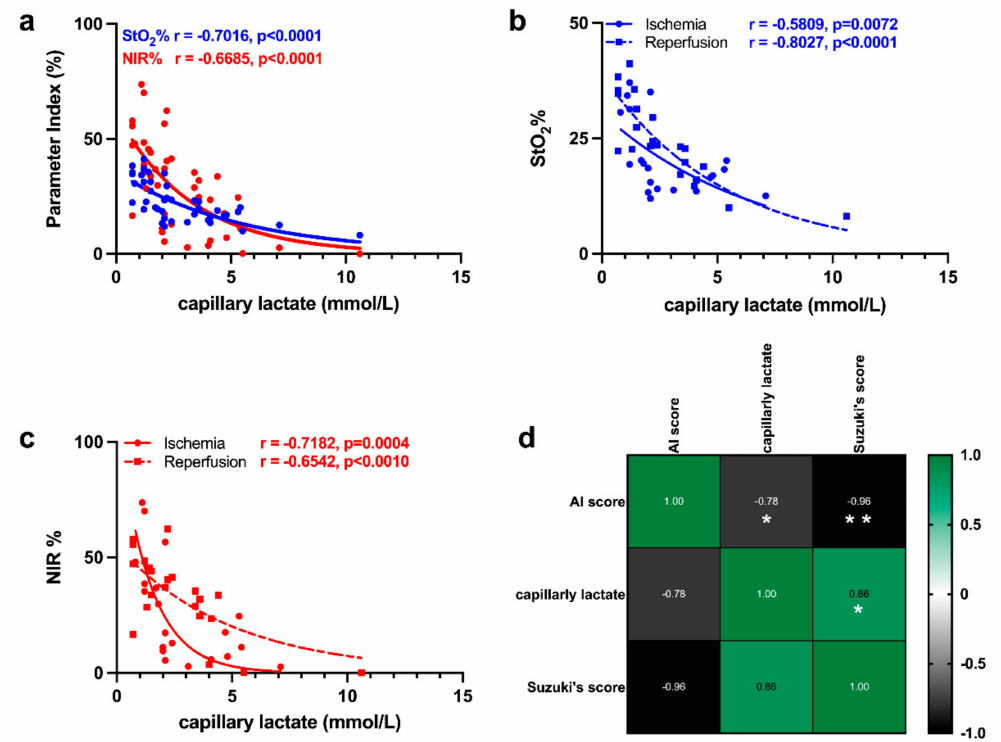
Figure 6. Correlation between optical and biological data. ( a ) Correlation between StO 2 %, NIR, and capillary lactates. ( n = 42) ( b , c ) StO 2 % and NIR correlation split into ischemic and reperfusion phases ( n = 42). ( d ) Correlation matrix of AI score, capillary lactates (mmol/L), and Suzuki’s score ( n = 22 per each variable for 5 pigs). Data are expressed as mean ± s.d. Spearman’s and Pearson’s correlation significance: * p ≤ 0.05, ** p ≤